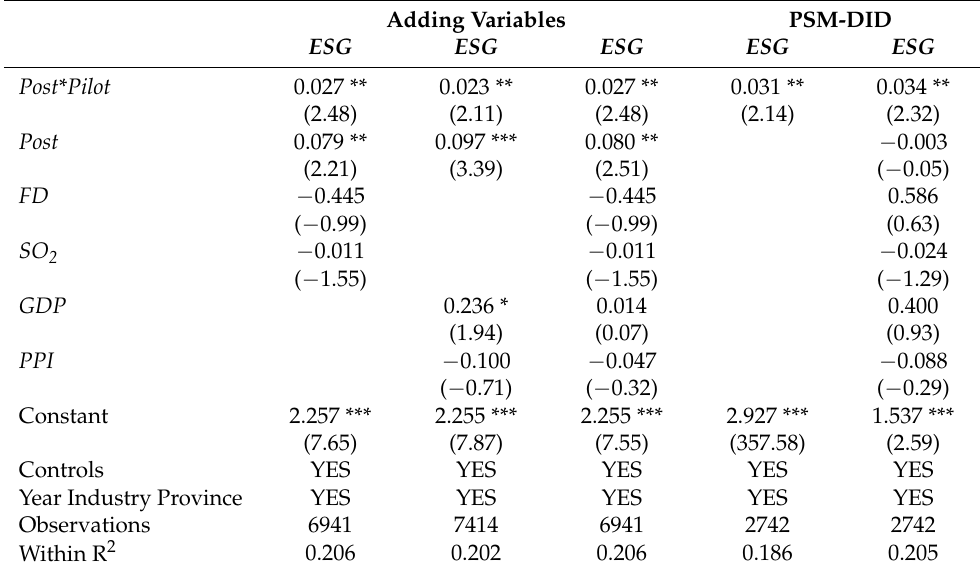
Table 9. Robustness check: adding control variables and